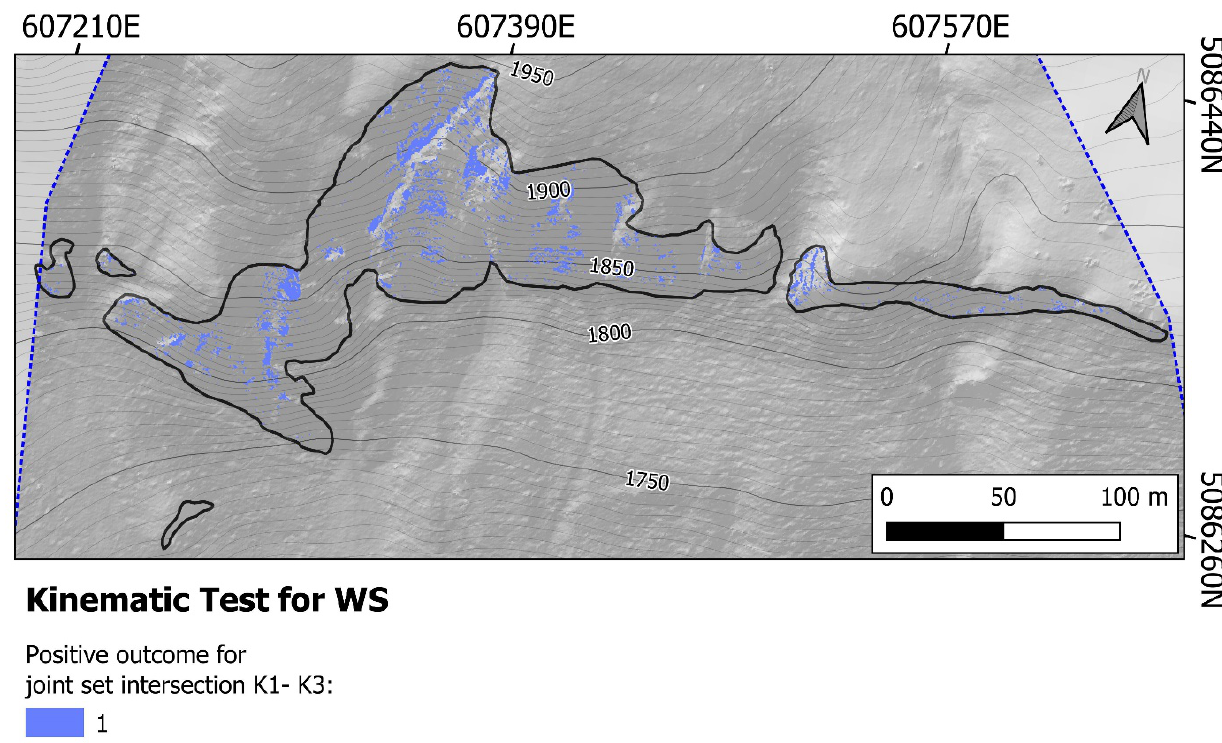
Figure A5. Image of the partial output file showing the kinematic test for WS performed considering only the intersection between joint set K1 and K2.